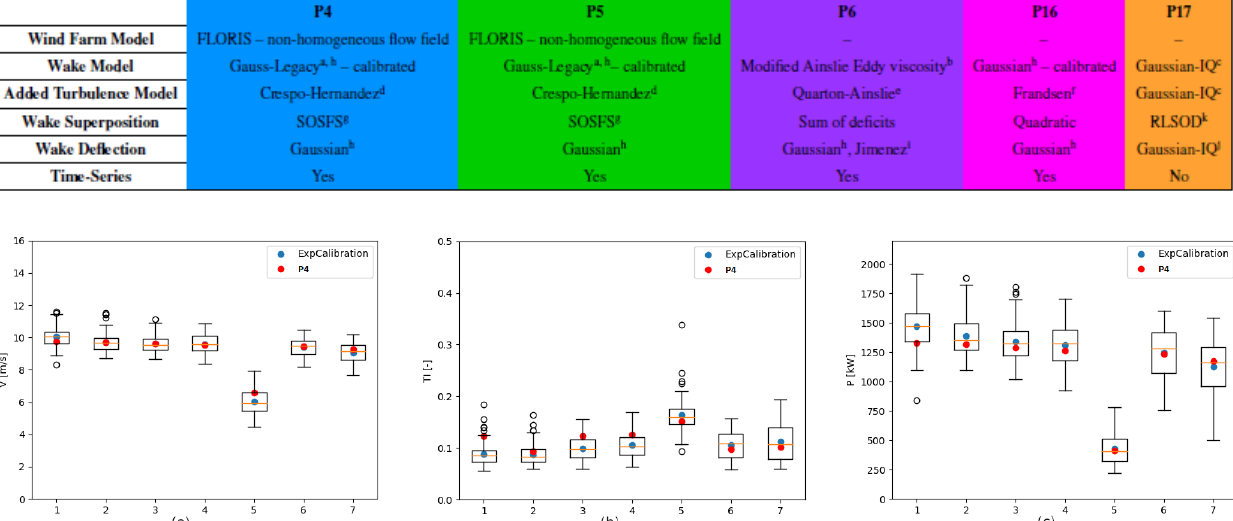
Figure 3. P4: the y axes show (a) velocity (ms − 1 ), (b) turbulence intensity (TI, –), and (c) power ( P , kW). Comparison per SMV wind turbine (turbine numbering SMV1–SMV7 in x axis) between experimental data (boxplot), average values used for experimental calibration (ExpCalibration, blue circles), and simulation with calibrated parameters (P4, red circles). Bin direction = 210 ◦ ; bin wind speed = 10ms − 1 . Empty black circles represent outliers.